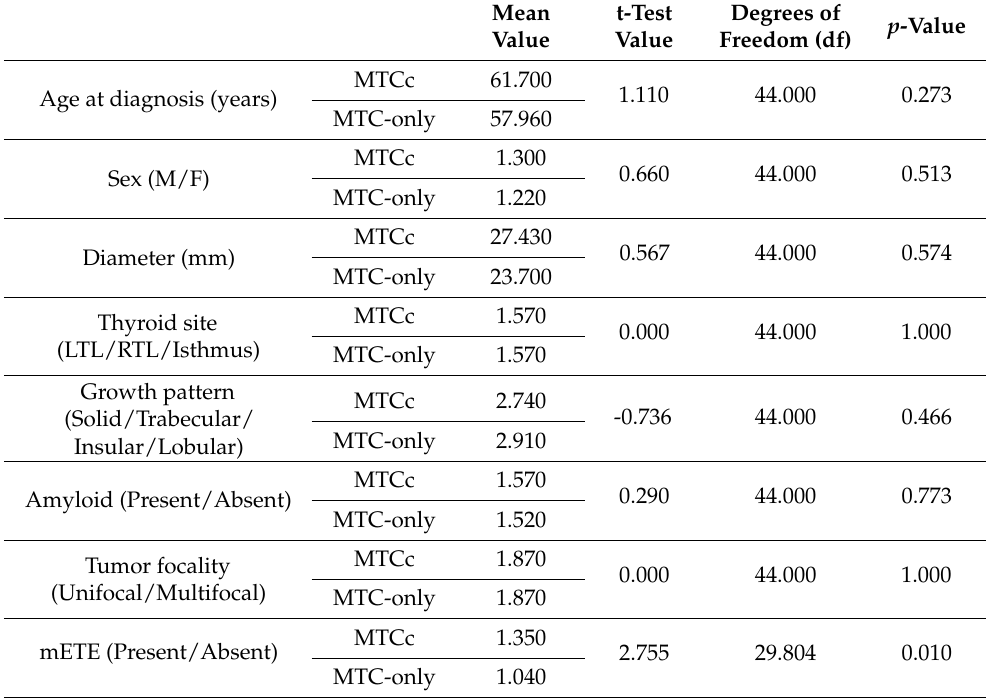
Figure 2. Pat hological features of TCTs’ MTC components. ( A ) classical solid MTC growth pattern (HE, ×200); ( B ) stromal amyloid present in the MTC component (HE, ×200); ( C ) lymphovascular invasion due to the MTC component (HE, ×200); ( D ) lymph node metastasis due to the MTC component (HE, ×100); strong and diffuse positivity of the MTC component for ( E ) calcitonin (IHC, anti-calcitonin antibody, ×100) and ( F ) chromogranin (IHC, anti-chromogranin antibody, ×100). Table 5. Pathological characteristics of the TCTs’ MTC components compared to MTC -only tumors.